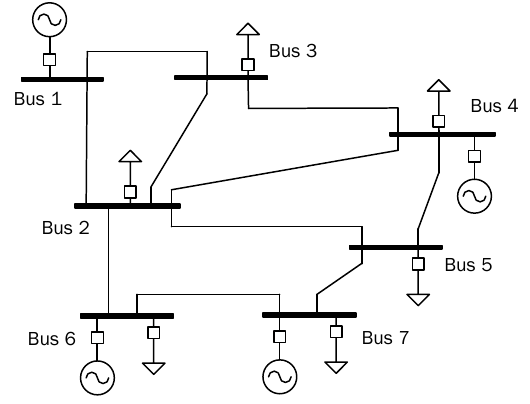
Fig. 7. Diagram of a 7-bus test